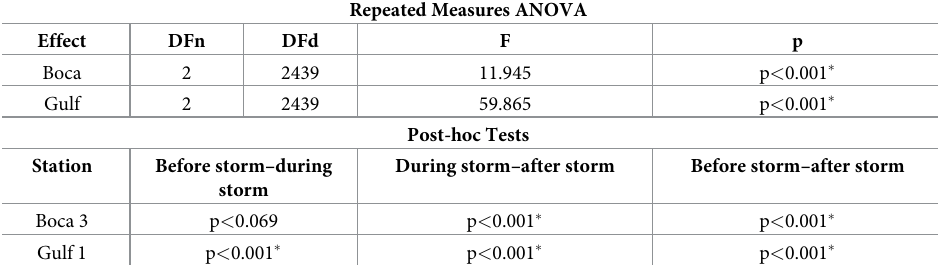
Table 4. Repeated measures ANOVA and post-hoc test on total fish detections for stations Boca 3 and Gulf 1. Repeated Measures ANOVA